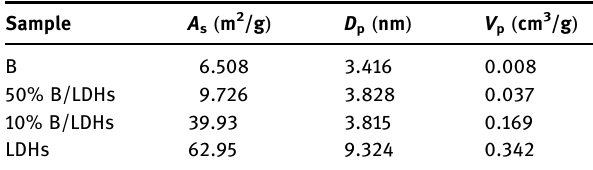
Table 1: Speci fi c surface area ( A s ) and pore data ( D p , V p ) of B, B/ LDHs, and LDHs samples